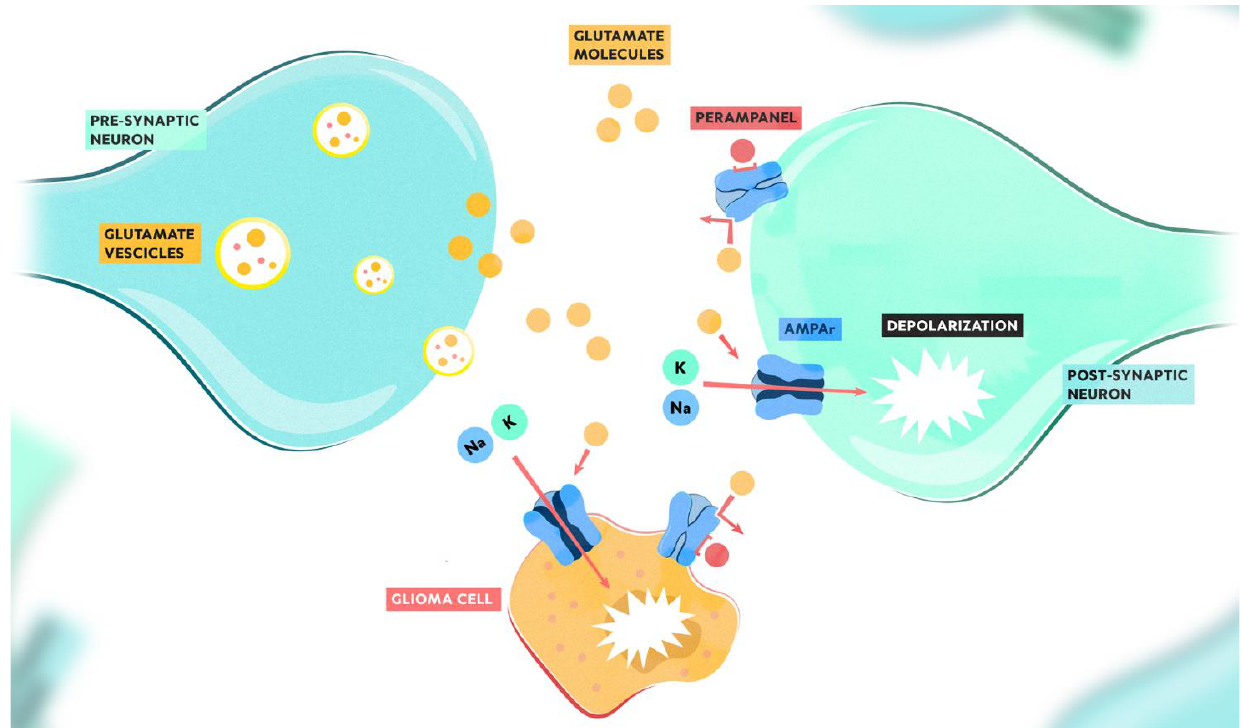
Figure 2. Mechanism of action of perampanel and its potential role in antitumor growth.